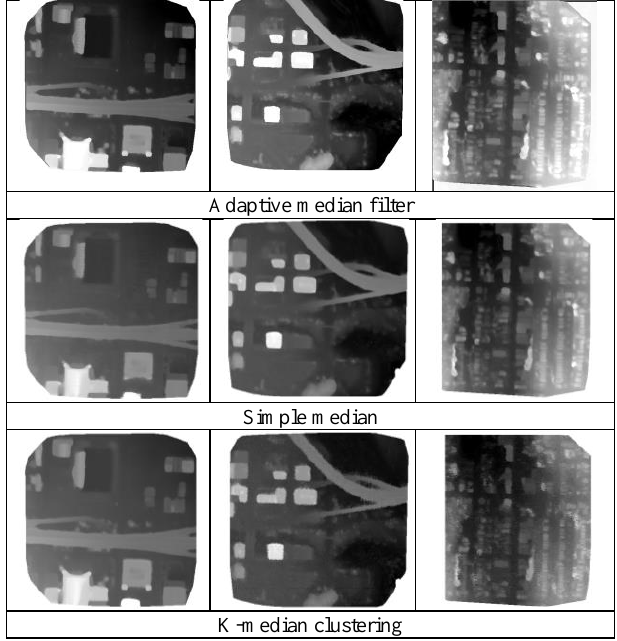
Figure 4. The fusion results of the three datasets using adaptive spatiotemporal fusion, the adaptive median filter, simple median filter, and C-median clustering. We evaluate the results of the adaptive spatiotemporal fusion statistically by showing a comparison between different values of 𝜎 ℎ for all classes, and a comparison between other existing approaches. We compared the results of the proposed adaptive spatiotemporal fusion to the ground truth height data (from Table 2. The choice categories for 𝜎 ℎ . LiDAR) and measured the accuracy of each dataset to a 6-meter level of difference. The results are shown in tables 3, 4, and